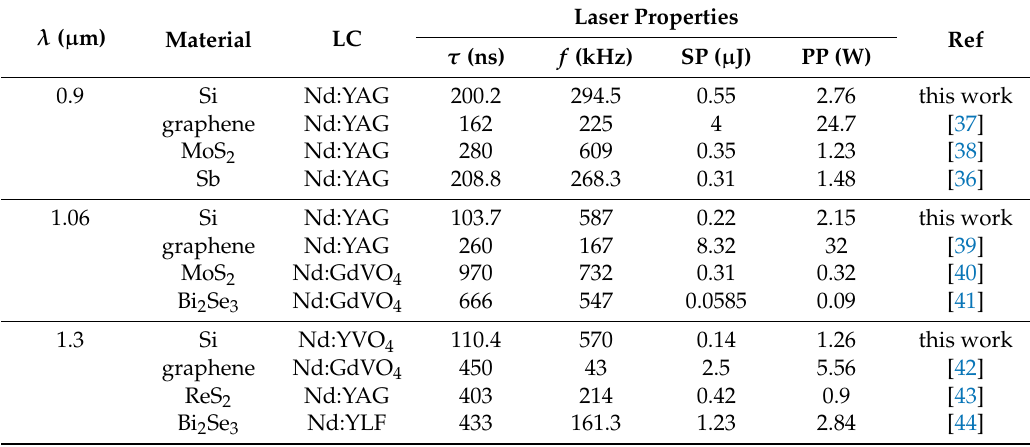
Table 2. Passively Q-switching performance for solid-state laser of Si nanosheets and some typical 2D